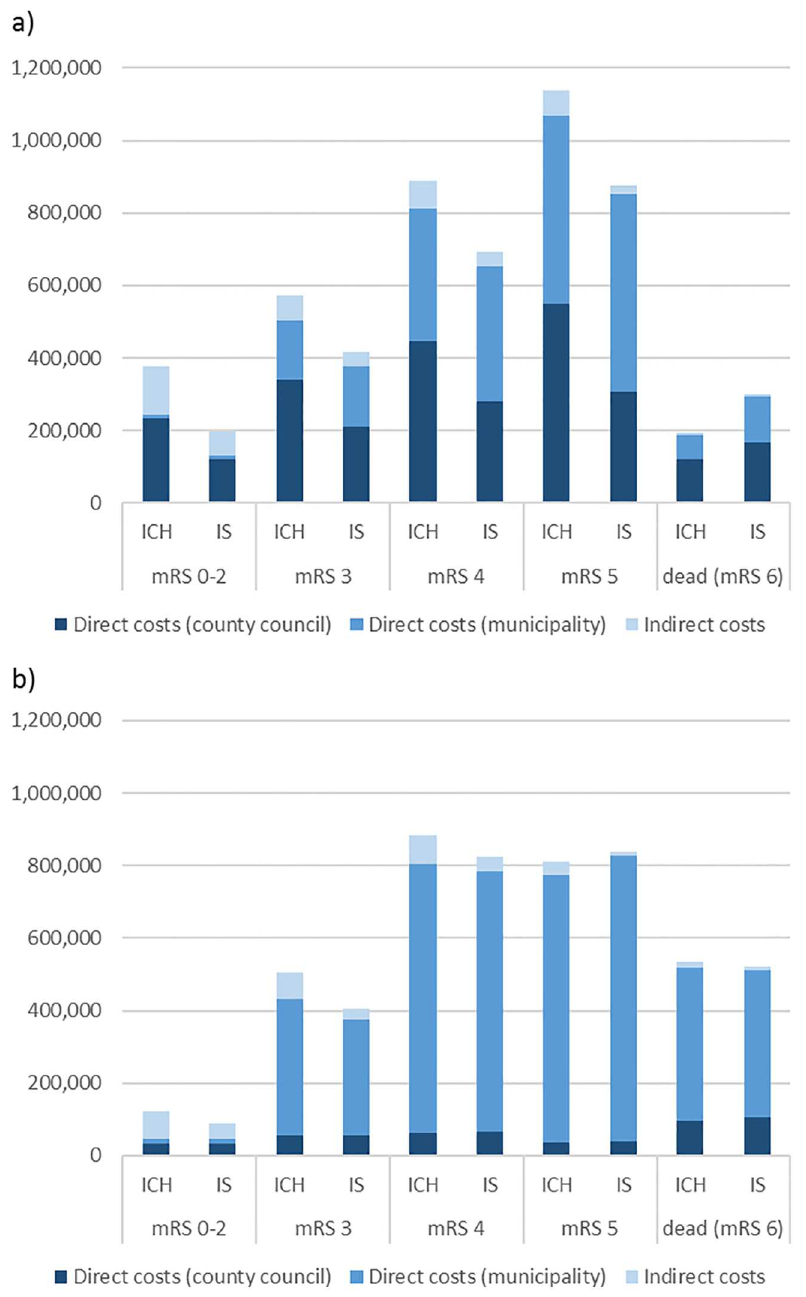
Fig 2. First (a) and second (b) year cost by functional ability and stroke type, per